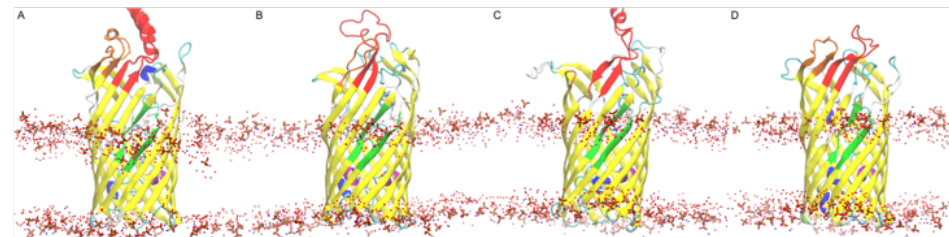
Figure 12. Lipid bilayer polar atom locations with respect to the: ( A ) b2344 ; ( B ) vc1042 ; ( C ) vc1043 ; and ( D ) vca0862 FadL proteins after equilibration and